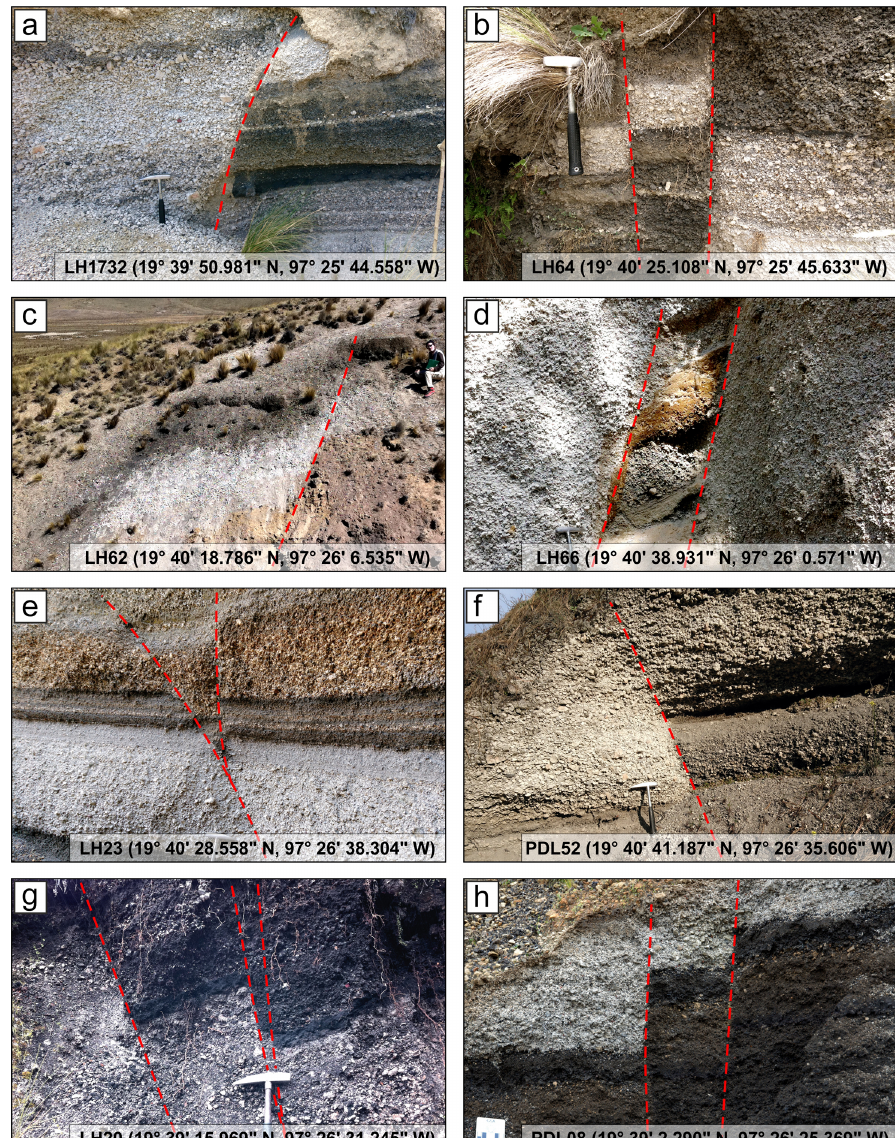
Figure 2. Photographs of faults in the Cuicuiltic Member along the structures mapped in Fig. 1.